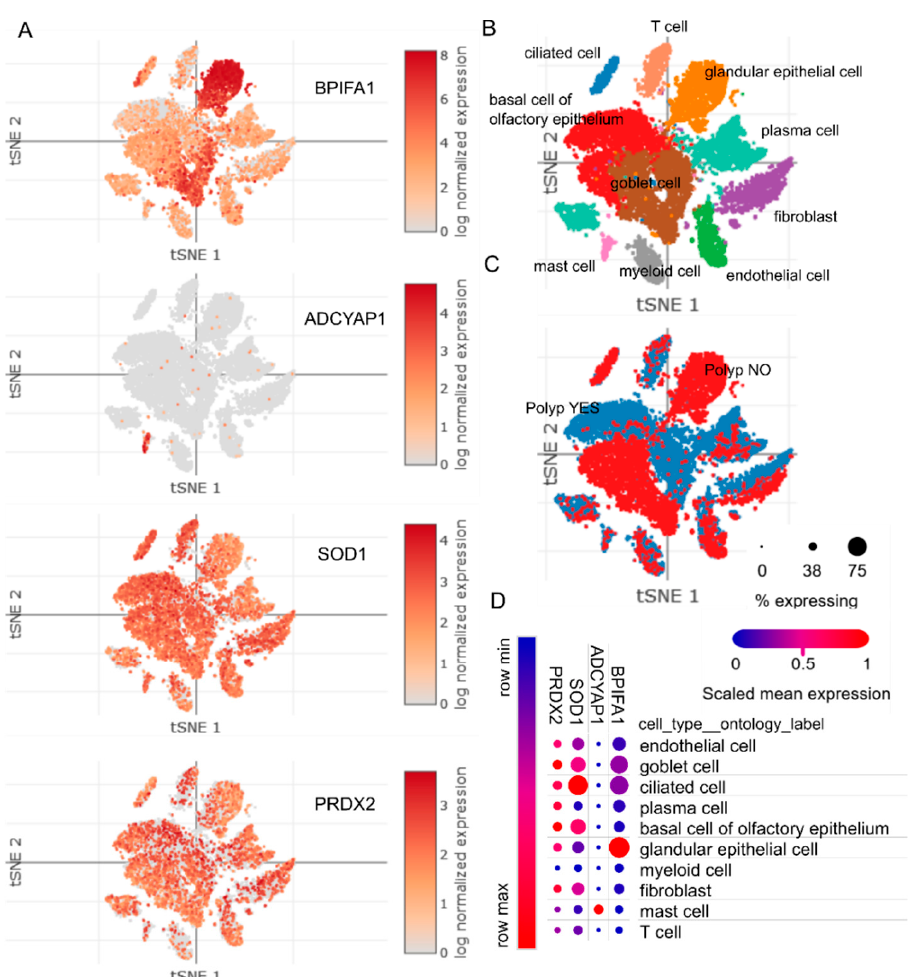
Figure 3 . Single-cell landscape of human surgical chronic rhinosinuitis samples. ( A ) t-distributed Stochastic Neighbor Embedding (tSNE) of jointly analyzed single-cell transcriptomes of 18,036 cells from 12 chronic rhinitis samples annotated by ( B ) cell type and ( C ) disease status. ( D ) Dot plot of selected transcripts mapped onto cell types across all samples. Image credit: The Broad Institute (Cambridge, MA, USA) Single Cell Portal ID SCP235 (singlecell.broadinstitute.org/single_cell accessed on 14 April 2022)